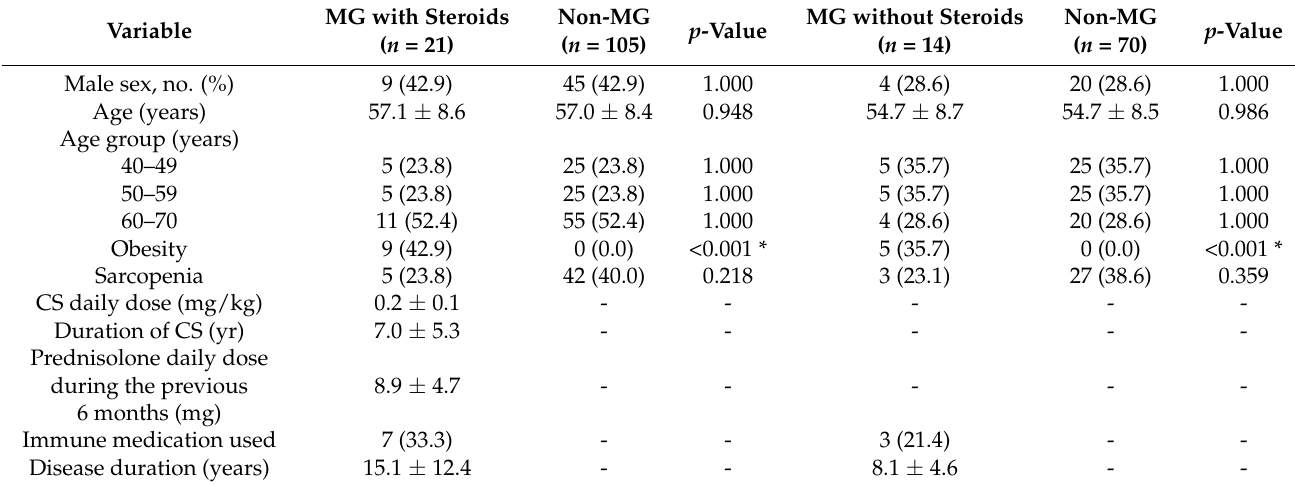
Table 4. Clinical characteristics of patients with MG and sex- and age-matched controls according to steroid